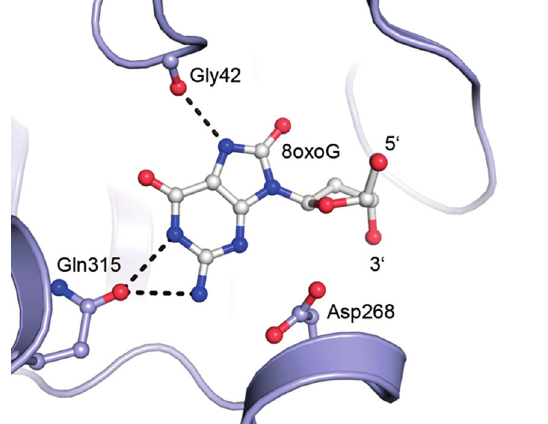
Figure 1. Structural details of 8oxoG base flipped into the lesion recognition pocket of OGG1 (Protein Data Bank deposition 1EBM [7]). The protein backbone is shown as a blue ribbon/helix. Selected amino acid side chains and the 8oxoG base are shown as ball-and-stick. Hydrogen bonds between the protein and 8oxoG are shown as dashed lines. Asp268 is the catalytic residue in OGG1. Symbols 5 ′ and 3 ′ indicate the position of the 5 ′ and 3 ′ phosphodiester links in the